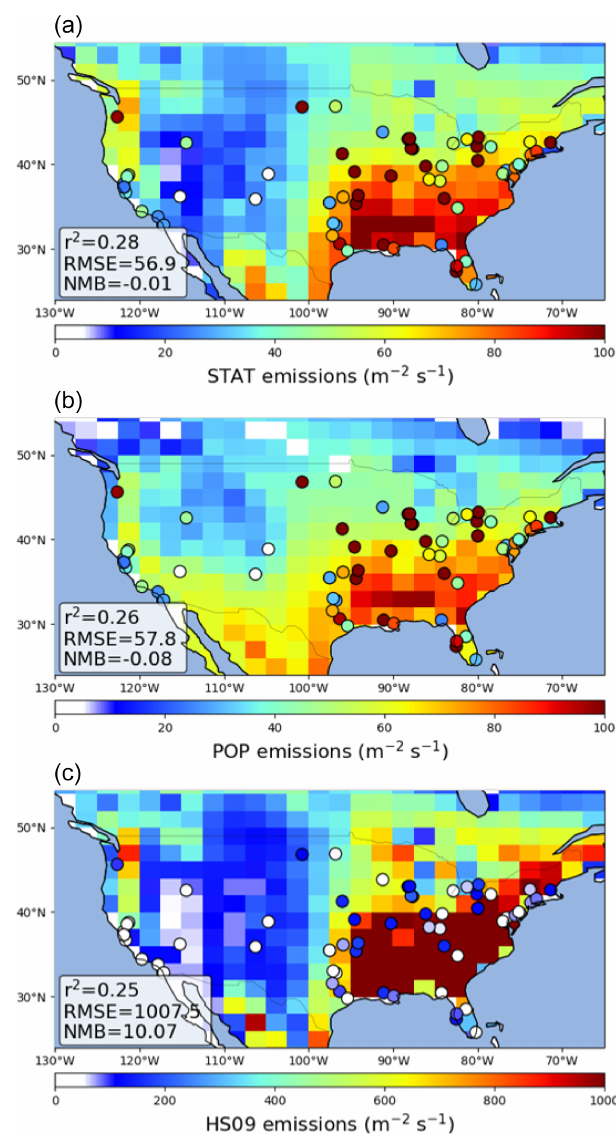
Figure 8. Comparison of GEOS-Chem simulated emission fluxes of fungal spores to emission fluxes derived from AAAAI observations for the statistical model (a) , the population model (b) and the HS09 model (c) . Note the different scale for the bottom figure. Statistics describing the comparisons are shown